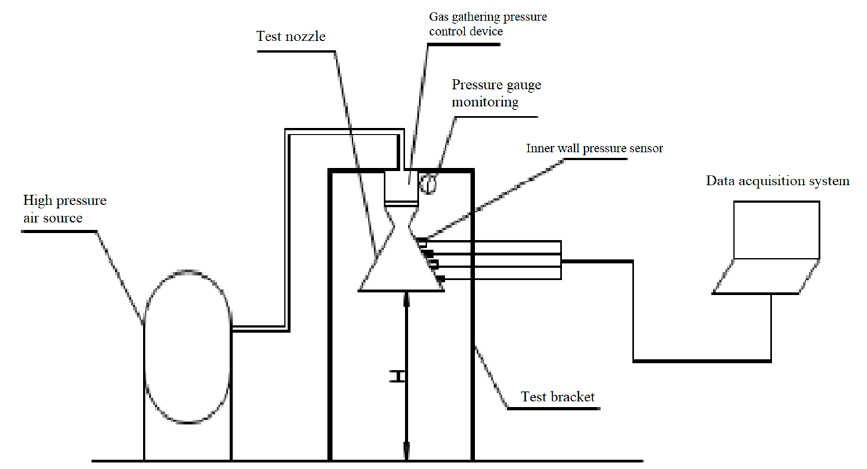
Figure 2. Schematic diagram of the test analysis system.